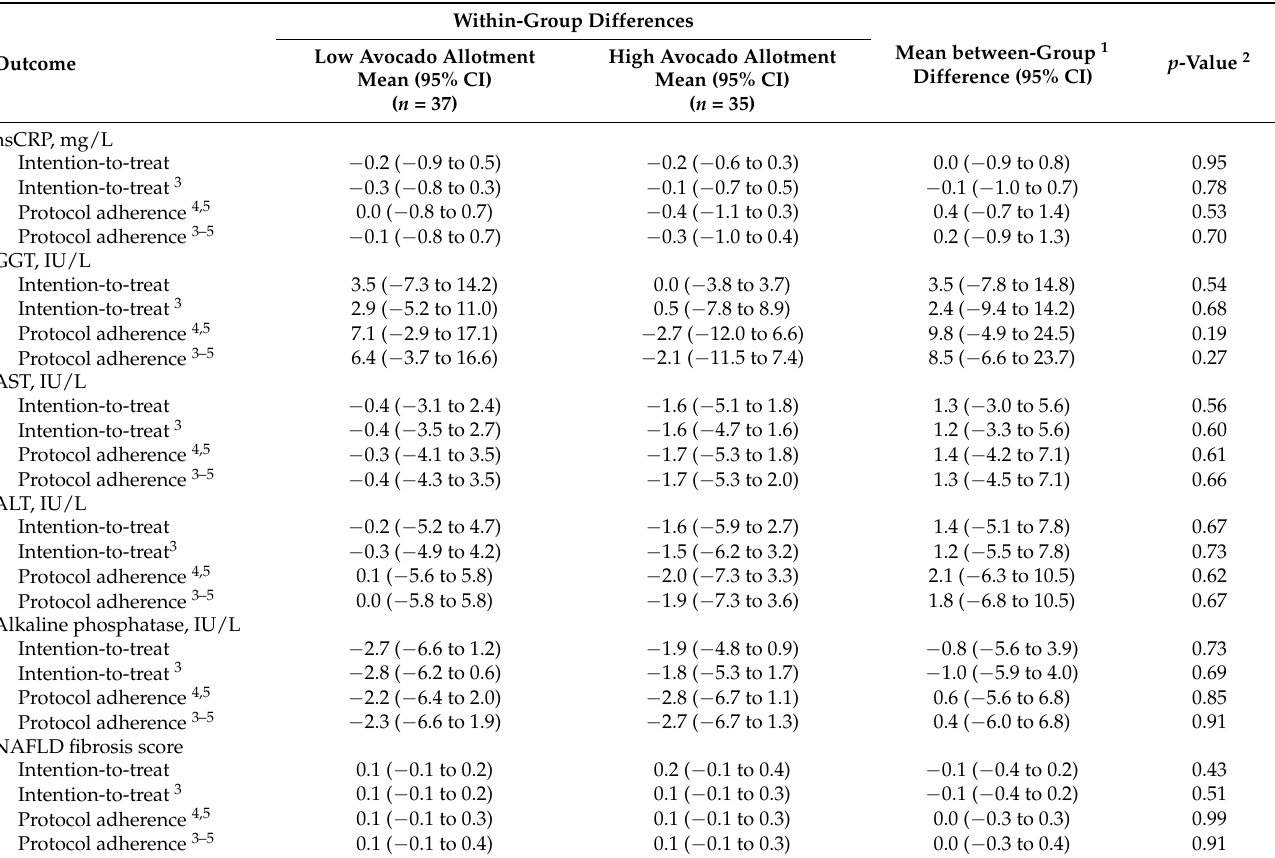
Table 2. Changes in hepatic function outcomes at 6 months, per intention-to-treat and protocol adherence